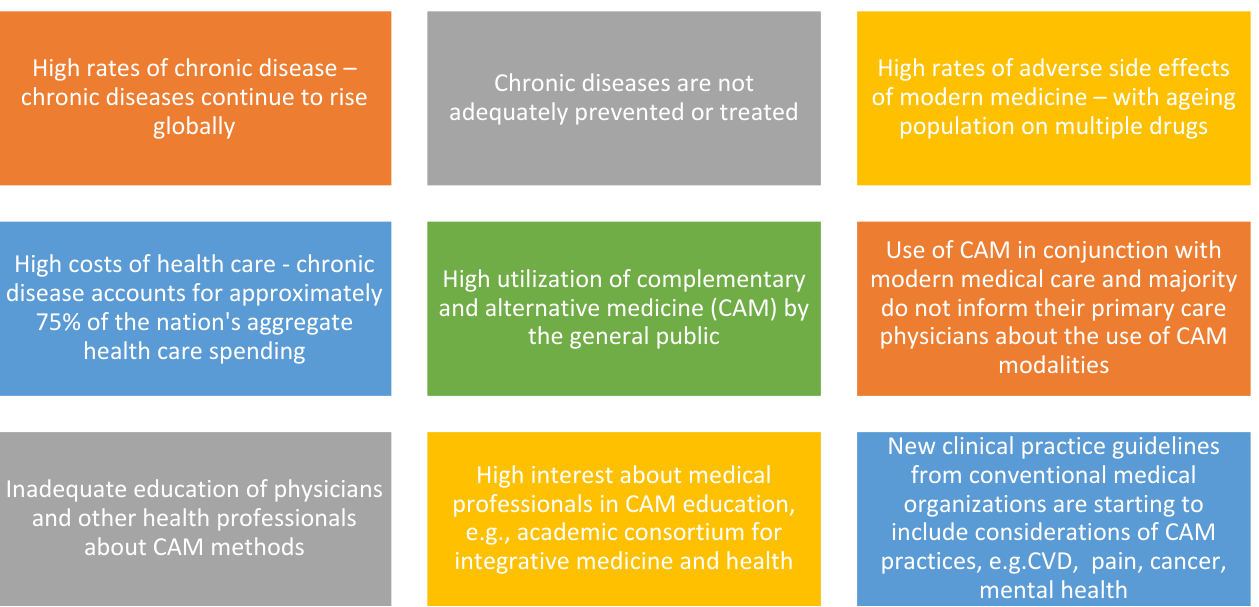
Figure 1. Trends driving integration of TCIM in contemporary healthcare. TCIM: Traditional, Complementary and Integrative Medicine; CVD: cardiovascular disease.